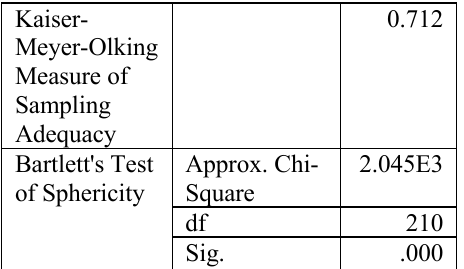
Table 01: KMO and Bartlett’s